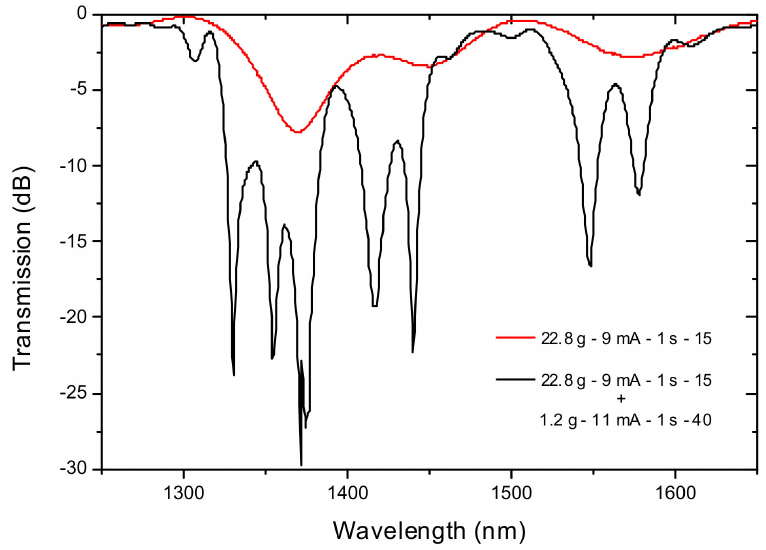
Figure 20. Evolution of the grating spectrum during the fabrication spectrum. Adapted from